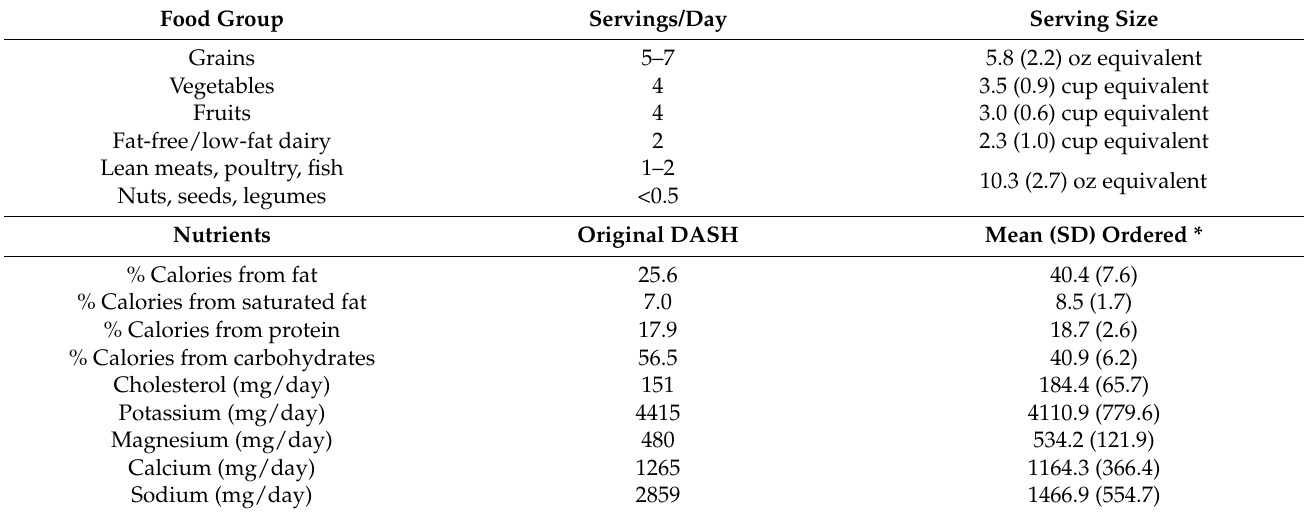
Table 1. Intervention goals and achieved servings or